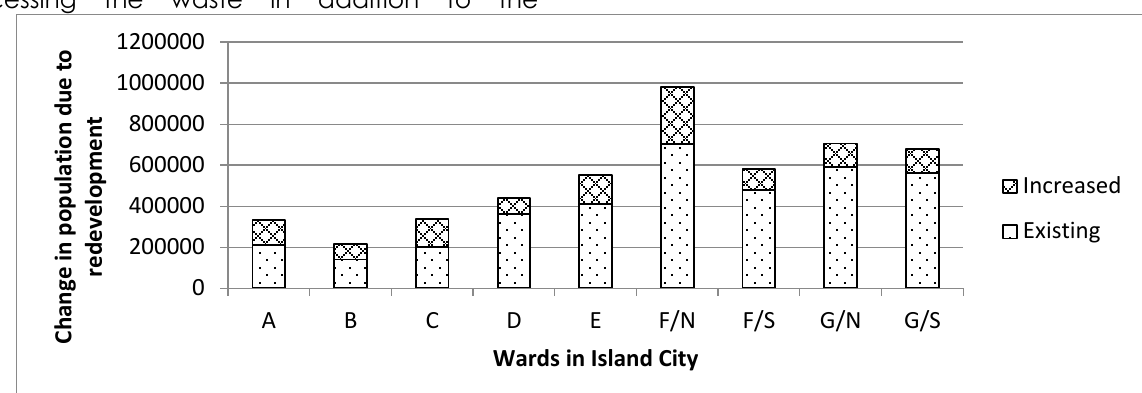
Figure 12. Increased population across the Island City if ‘cessed’ properties are demolished for the ‘smart’ development